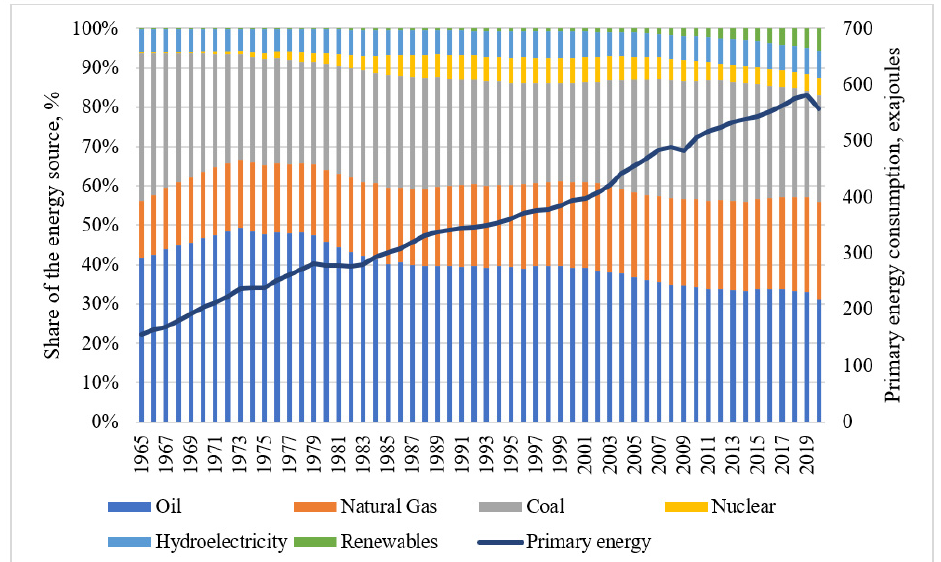
Figure 1. Global energy and fuel mix and energy consumption, 1965–2020. Source: compiled by author based on the BP’s Statistical Review of World Energy.